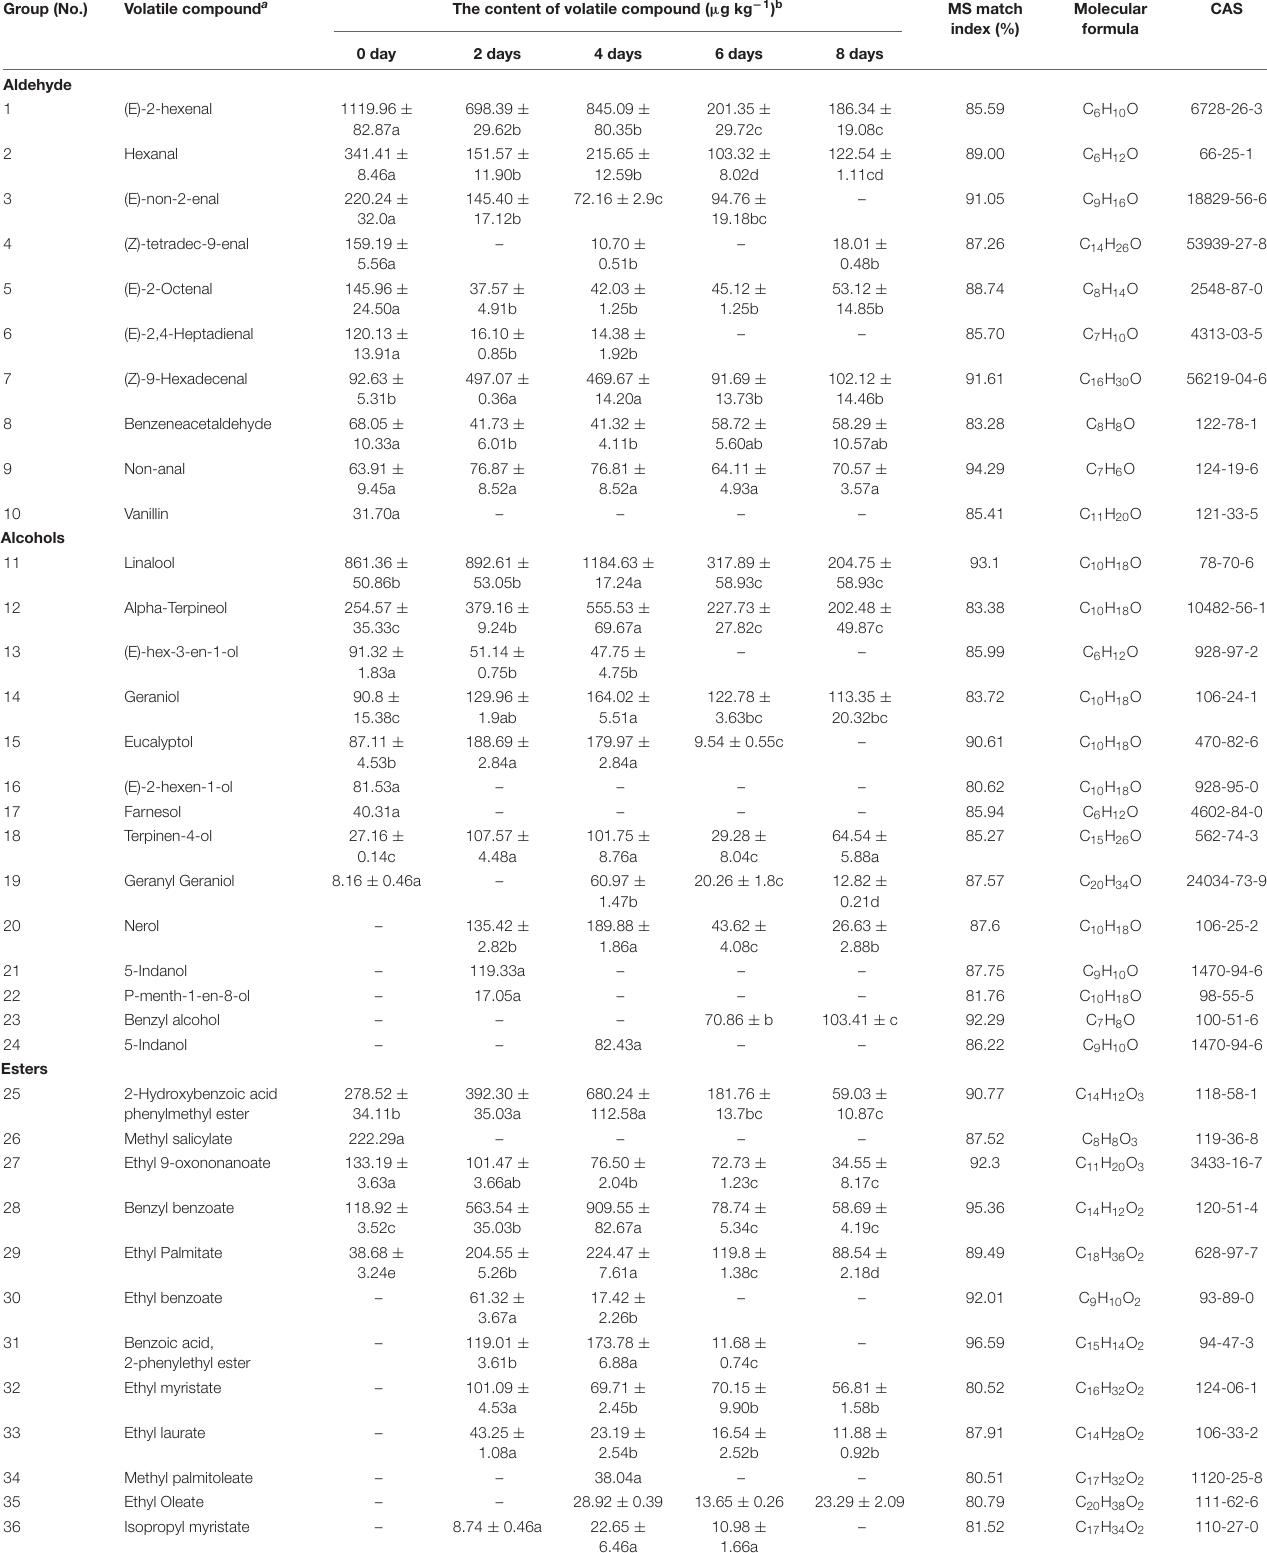
TABLE 1 | The composition and content of volatile compounds in cut lily during the postharvest process by headspace solid-phase microextraction gas chromatography-mass spectrometry (HS-SPME/GC–MS) methodology. Group